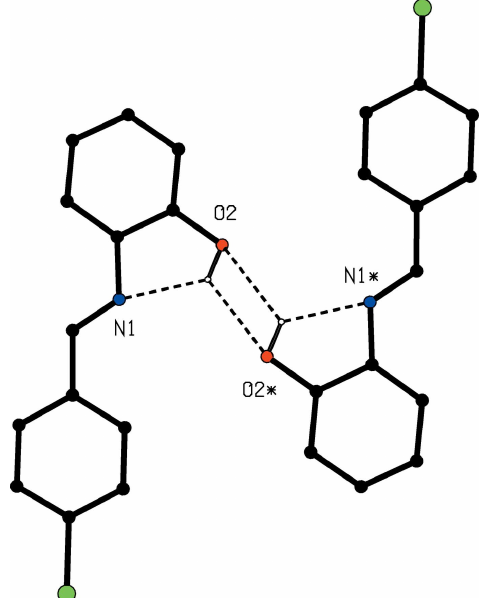
Figure 3 Part of the crystal structure of compound (I), showing the O—H (cid:2)(cid:2)(cid:2) O interaction between an inversion-related pair of molecules. For the sake of clarity, the unit-cell outline and H atoms bonded to C atoms have been omitted. Atoms marked with an asterisk (*) are at the symmetry position (1 (cid:4) x , 2 (cid:4) y , 1 (cid:4) z